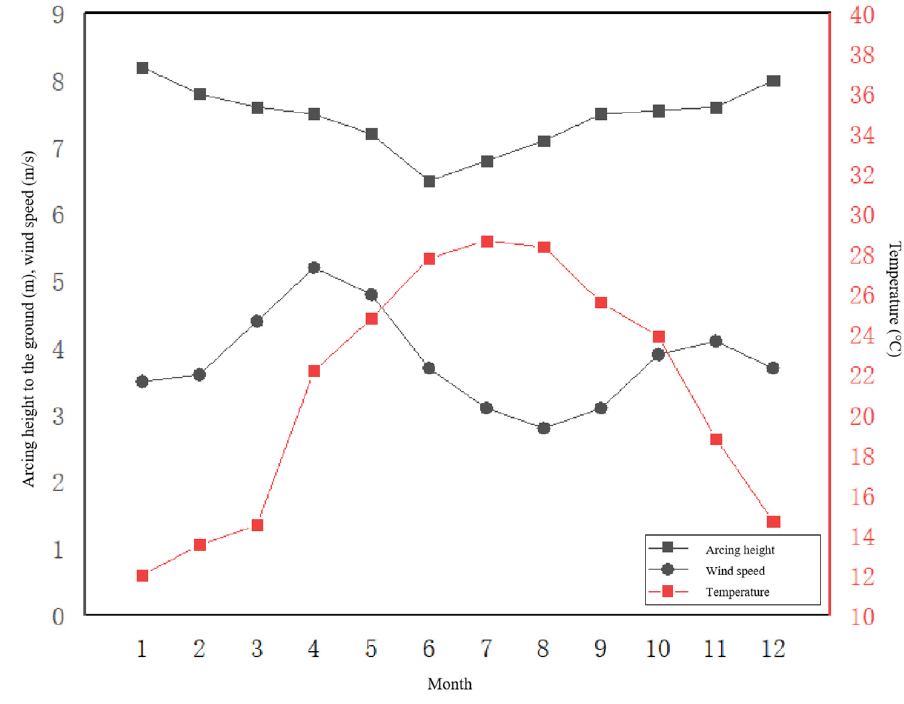
Figure 9. Monthly variation curves of arboreal height, air temperature, and wind speed to the ground.